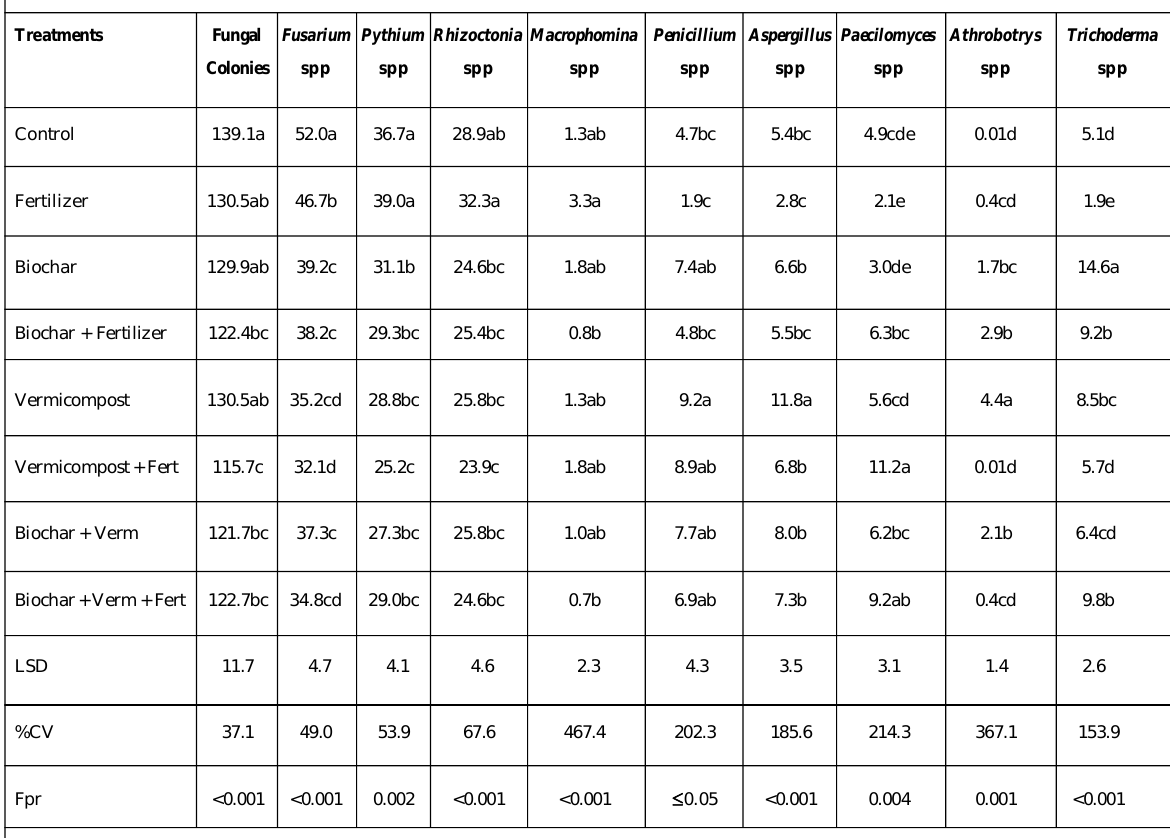
Table 11: Effect of biochar and vermicompost on fungal populations ( × 10 3 CFU/g soil) two weeks after planting of common bean during short rains season of 2014